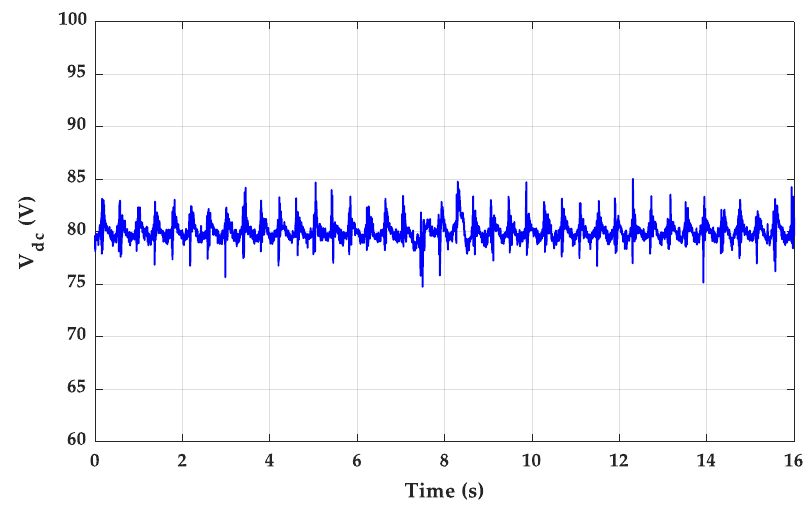
Energies 2019 , 12 , x FOR PEER REVIEW Figure 13. The dc-side voltage response (Experiment 2). Figure 13. The dc-side voltage response (Experiment 2).